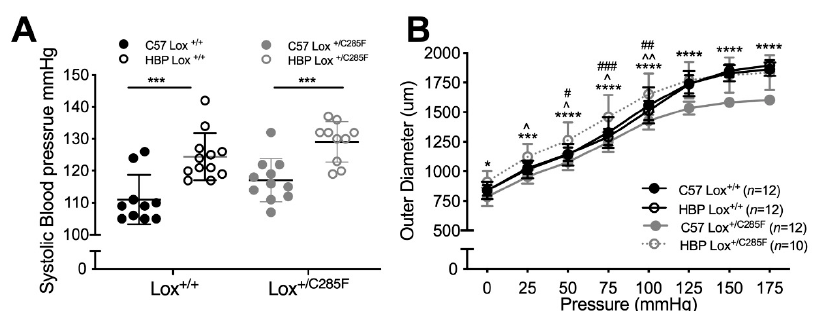
Figure 2. HBP congenic background increases male Lox +/C285F aortic dilation rate. ( A , B ), HBP back- ground increases SBP in Lox +/+ and Lox +/C285F mice (( A ), Lox effect p < 0.05, HBP effect p < 0.0001, two-way ANOVA, followed by Sidak multiple testing with p values shown in the graph) and pro- duces larger diameter vessels in Lox +/C285F males by 3 months of age (( B ), *—C57 Lox +/C285F vs. HBP Lox +/C285F , ˆ—C57 Lox +/+ vs. HBP Lox +/C285F , and # —HBP Lox +/+ vs. HBP Lox +/C285F , two-way ANOVA). C57 Lox +/+ and C57 Lox +/C285F mice are those used in Figure 1. For all tests * , ˆ , # p < 0.05,